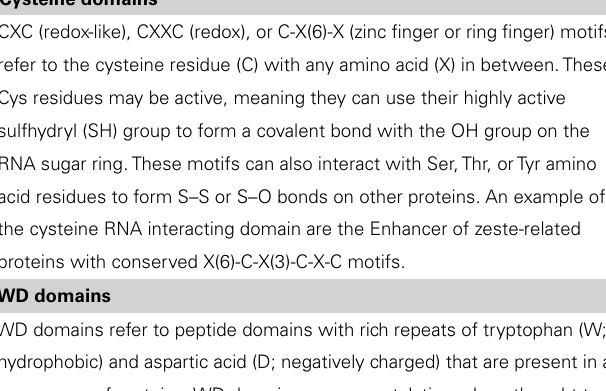
Table 3 | Protein:RNA interacting domains. Cysteine